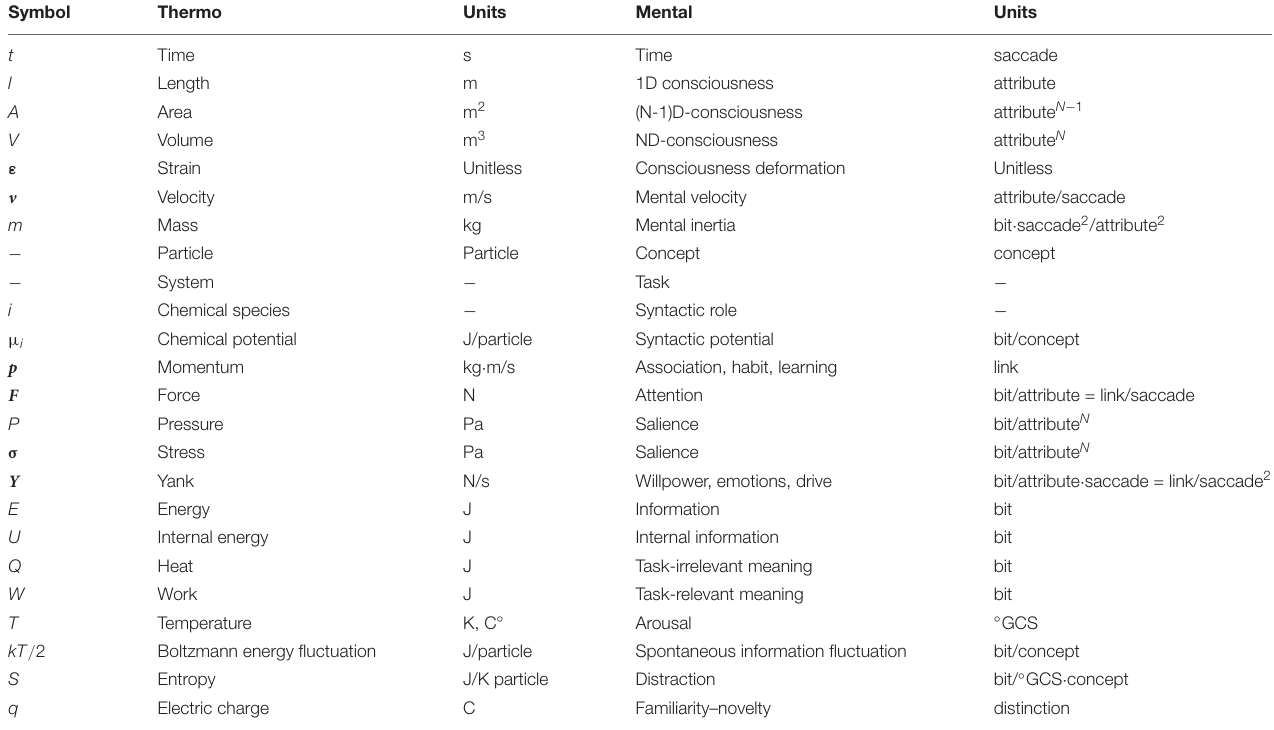
TABLE 1 | Analogy between thermodynamic and mental